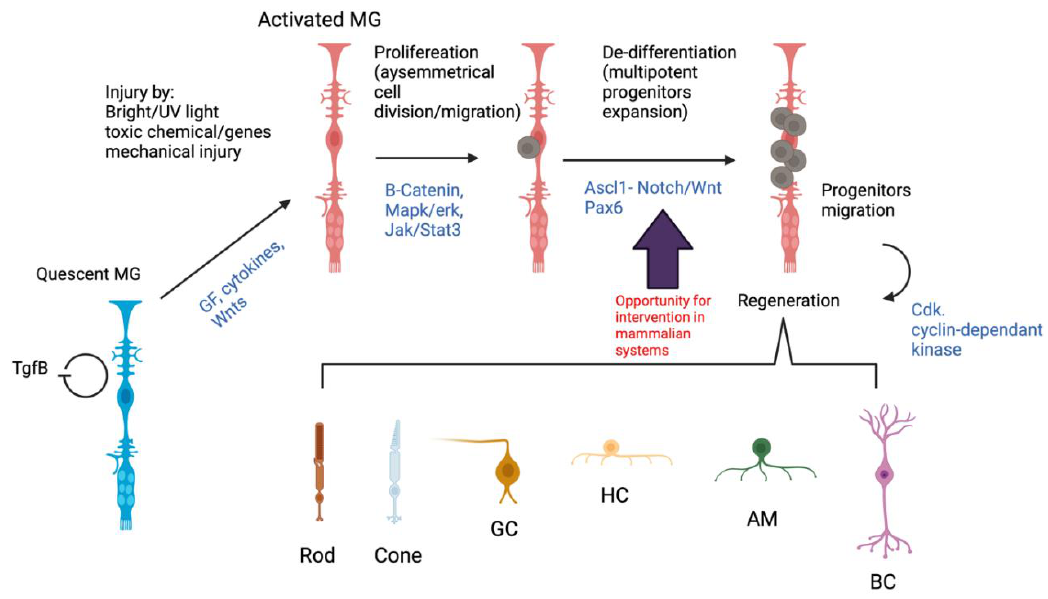
Figure 2. Müller glia regeneration-associated molecular cascades in zebrafish. A hypothetical pathway representing Müller glia activation in response to injury and the sequence of events that leads to retinal regeneration in zebrafish (black text). Müller glia are quiescent in absence of injury, a process regulated by TgfB/Smad pathway. Upon injury, Müller glia are encouraged start reprogramming and enter the cell cycle in a complex of events involving B-catenin, Mapk/erk and Jak/Stat3 signalling pathways, which stimulate proliferation. These pathways stimulate injury-dependant Ascl-1 expression, which regulates the generation of Müller glia-l-derived progenitor cells (MGPCs). Those sequences of events also occur in mammalian systems. However, the MGPCs in zebrafish retina expand and migrate to regenerate the injured retina. This regeneration potential is inefficient in mammalian systems. Intervention at key steps in the zebrafish Müller glia reprogramming might stimulate the regeneration potential in mammalian Müller glia (purple arrow).